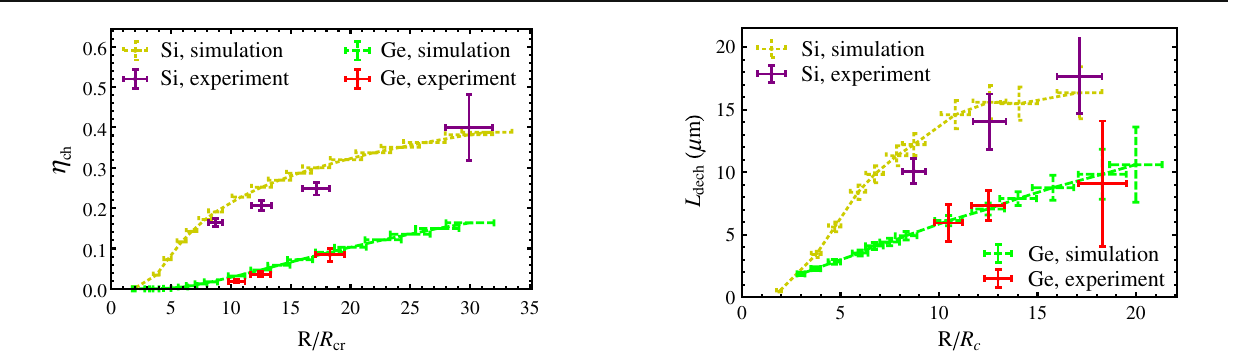
Fig. 6 The experimental and simulated dependence of the dechannel- ing length on the ratio of the bending radius to its critical value at ideal channeling orientation. The dechanneling length for the first silicon curvature of θ b = 315 µ rad, was not extracted because channeling and volume reflection peaks were too close, thus making the fit (8)–(11) practically inapplicable